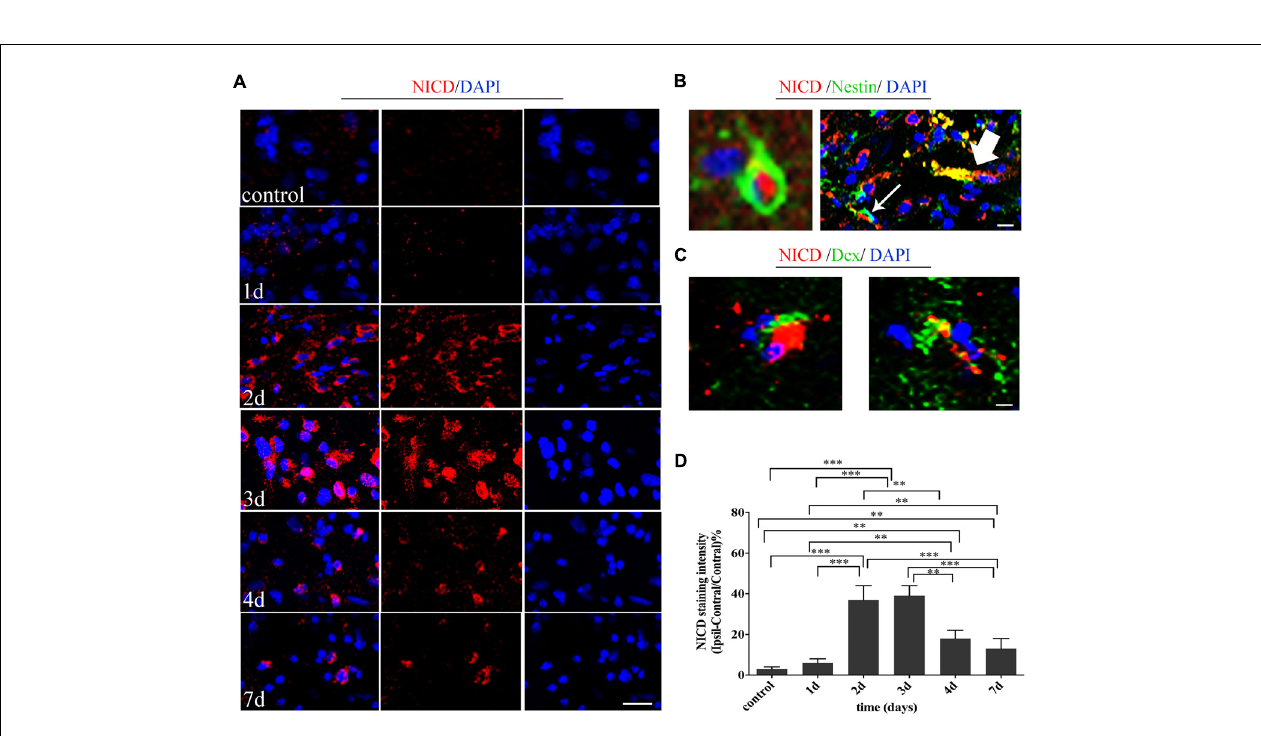
FIGURE 2 | Temporal evolution and spatial location of Noth1 signaling in ischemic striatum (STR). (A) Immunostaining of NICD before and at day 1, day 2, day 3, day 4, and day 7 after MCAO. Scale bar = 20 µ m. (B) Double immunostaining of NICD/Nestin at the ischemic boundary and the lesion of day 3 after MCAO. The thin white arrow and thick white arrow show the double location of the branched neural stem cell (NSC) and vessel-like NSC respectively. Scale bar = 10 µ m. (C) Double immunostaining of NICD/Dcx at the ischemic boundary of day 4 after MCAO. Scale bar = 10 µ m. (D) Quantification of NICD fluorescence intensity in ischemic STR. ∗∗∗ P < 0.001 versus day 2, day 3 and control, day 1, day 7. ∗∗ P < 0.01 versus day 4 and control, day 1, day 2, day 3. ∗∗ P < 0.01 versus day 7 and control, day 1.